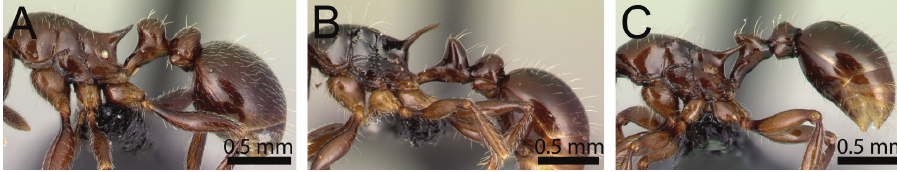
Figure 19. Mesosoma, waist segments, and first gastral tergite in profile. A T. ryanphelanae (CASENT0454495) B T. valky (CASENT0496394) C T. silvicola